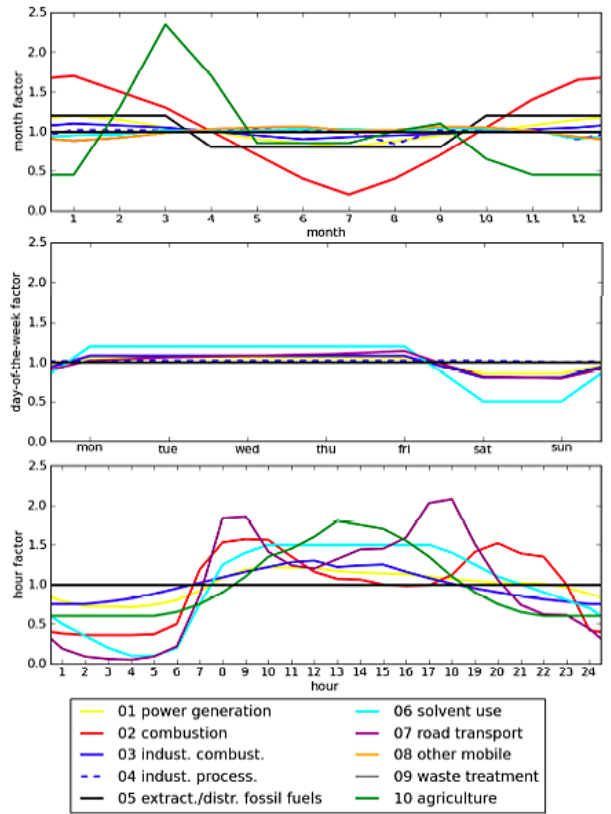
Figure 13. Monthly (top), weekly (middle) and hourly (bottom) time profiles applied to anthropogenic emissions in Europe for dif- ferent sectors (from Kuenen et al., 2011).